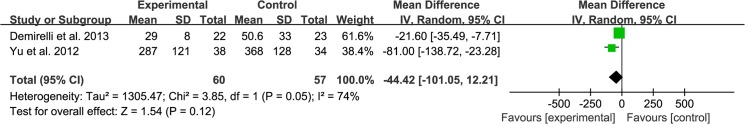
Forest Plots for Serum Level of BNP.